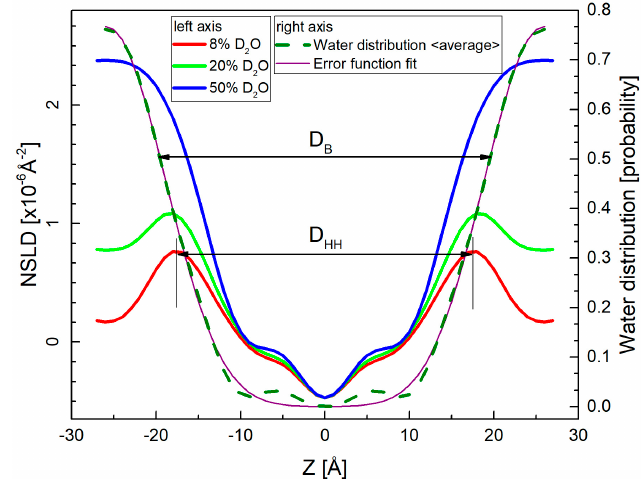
Figure 8. Neutron scattering length density (NSLD) profiles corresponding to the measurements at three different contrast conditions (left-hand axis). The high percentage of D 2 O in hydrating water provides the high contrast between hydrogen-rich bilayers and water. On the other hand, 8% D 2 O suppresses the contribution from water phase providing thus a direct characteristic of lipid bilayer in the head-to-head distance D HH . The contrast variation approach allows additionally, to calculate the water distribution (right-hand axis) by subtracting NSLD profiles obtained at multiple contrasts. The mean position of their averaged distribution or that obtained from Error function fitting determines the water/bilayer interface and thus the bilayer thickness D B [47].